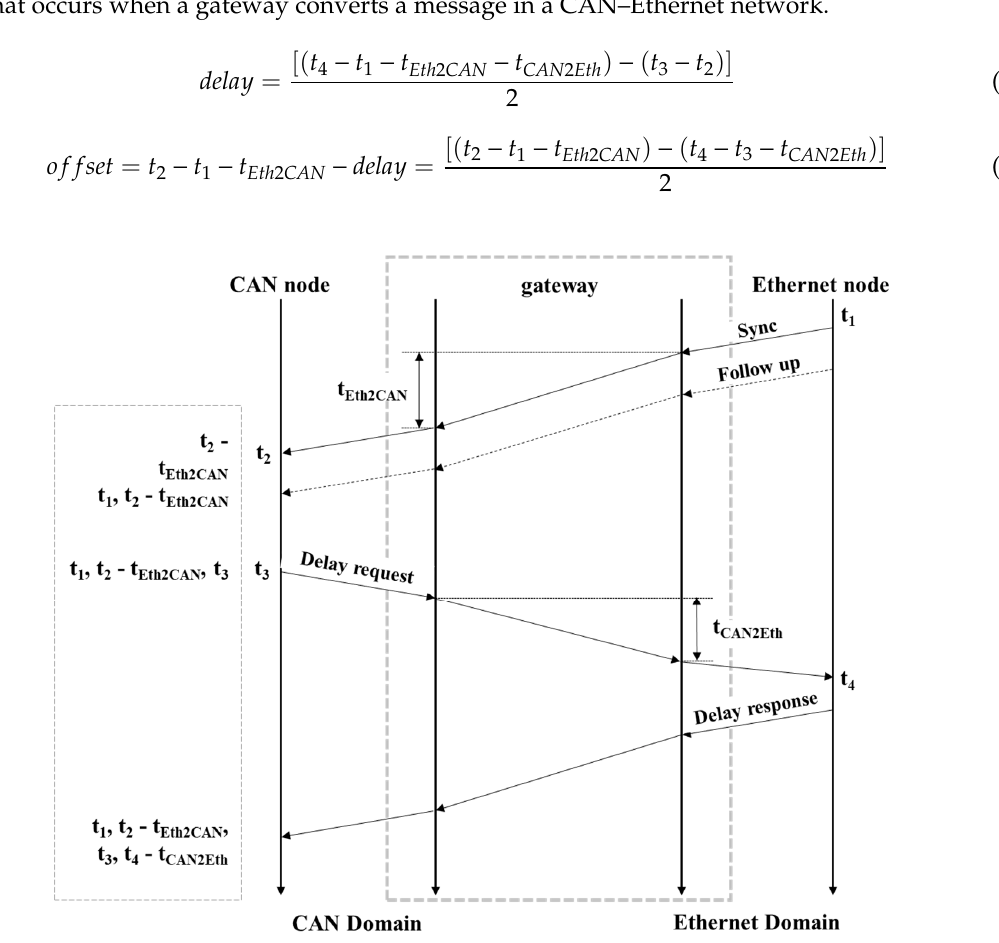
Figure 2. End-to-end mechanism in a CAN–Ethernet network with a gateway.